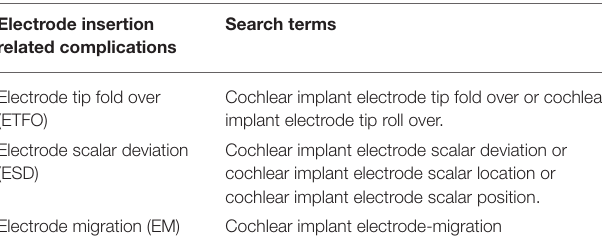
TABLE 1 | Search terms used in the identification of relevant literature to perform the systematic literature review. Electrode insertion related